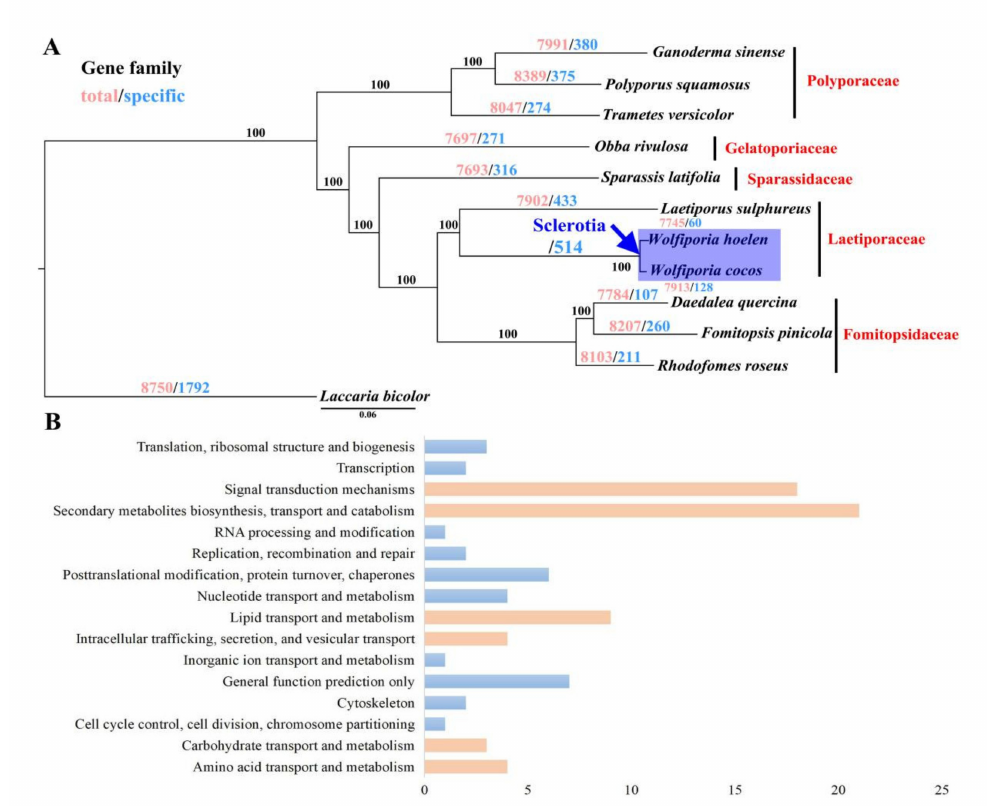
Figure 5. Phylogenetic analysis of Wolfiporia hoelen and related species inferred from ML of single- copy orthologous genes ( A ) and function of common expanded gene family in Wolfiporia hoelen and Wolfiporia cocos annotated with KOG ( B ). Note: The protein mutation rates compared with W. hoelen are: W. cocos 0.96%, L. sulphureus 17.53%, D. quercina 17.99%, R. roseus 18.01%, S. latifolia 19.58%, F. pinicola 18.26%, O rivulosa 20.57%, p. squamosus 21.88%, T. versicolor 22.21%, G. sinensis 22.81%, and L. bicolor